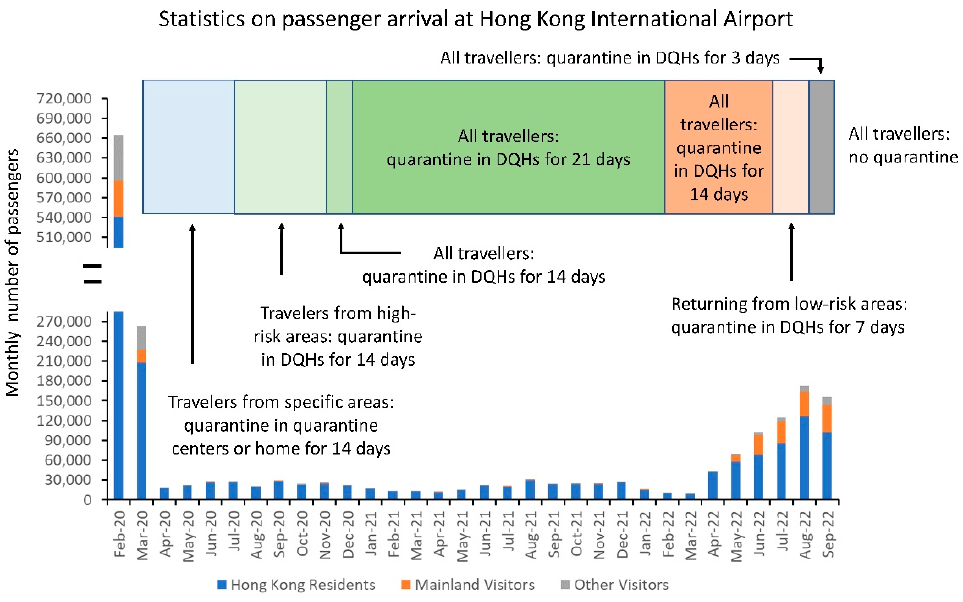
Figure 6. The number of inbound travelers, including Hong Kong residents and visitors from mainland China, arriving at Hong Kong International Airport. DQHs, designated quarantine hotels.